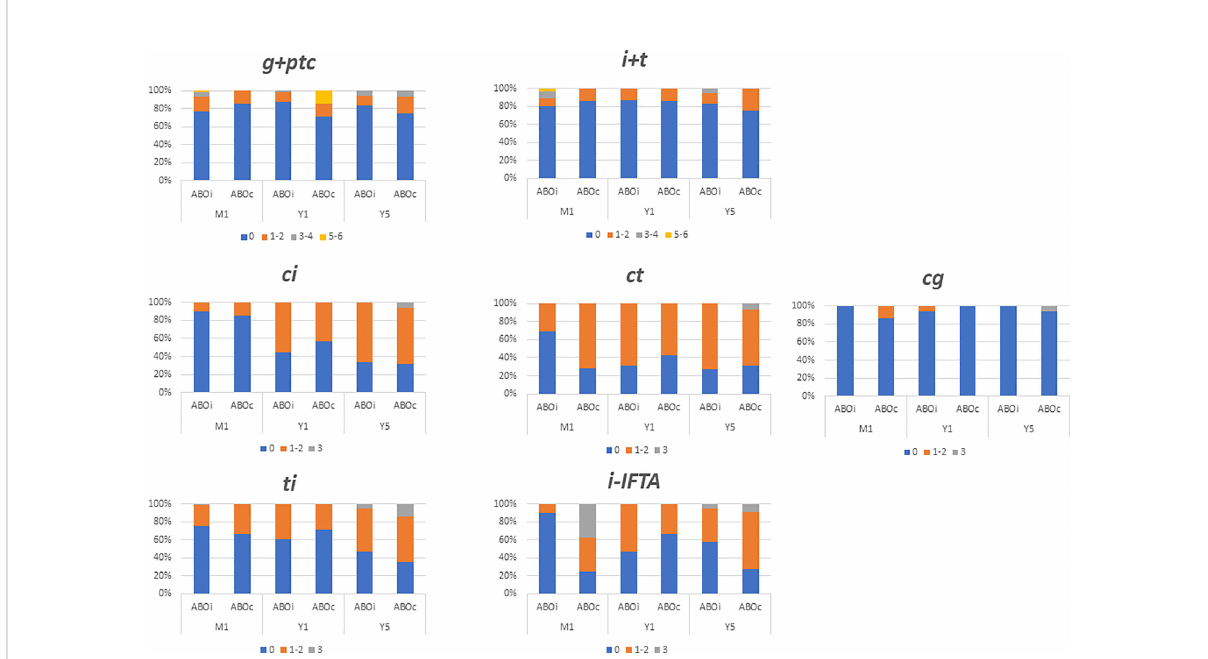
FIGURE 2 Comparison of biopsy fi nding at month one (M1), year one (Y1) and years fi ve (Y5) between ABO incompatible (ABOi) and ABO compatible (ABOc) recipients. Data are expressed in each colomn with the percentage of patients presenting the same banff score. i, interstitial in fl ammation; t, tubulitis; g, glomerulitis; ptc, peritubular capilaritis; ci, chronic interstial fi brosis; ct, tubular atrophy; cg, glomerular basement membrane double